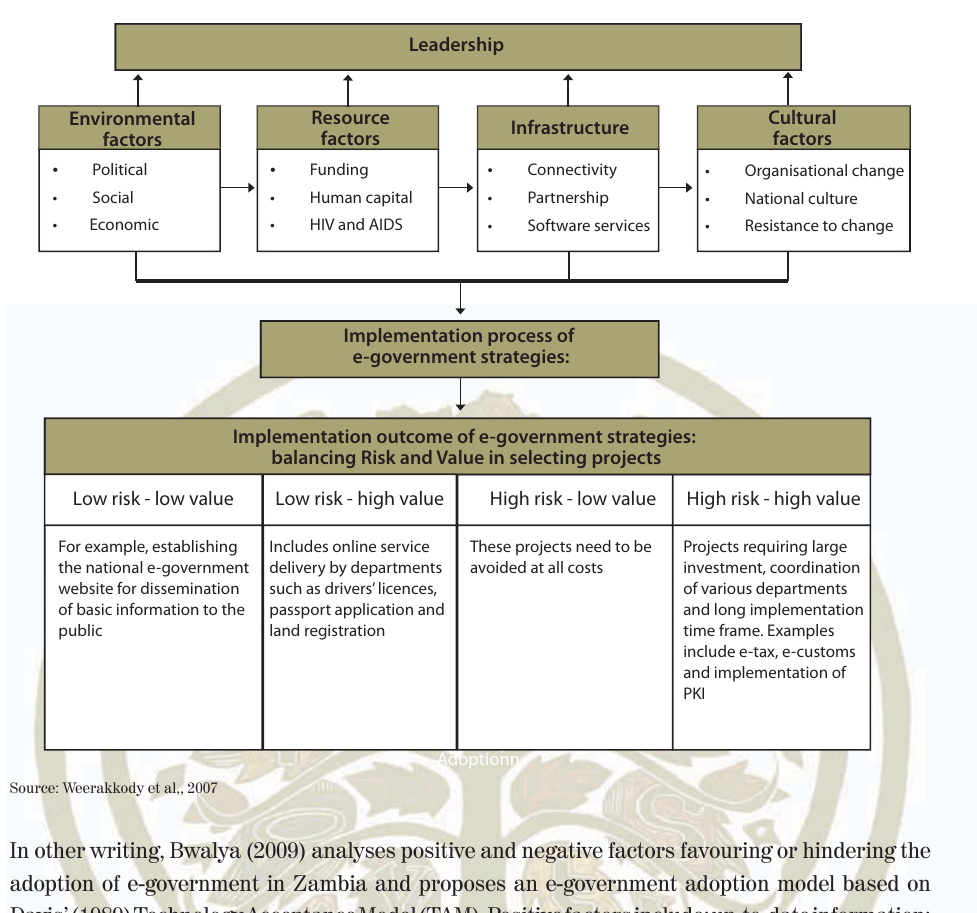
FIGURE 1: PERSPECTIVE ON A FRAMEWORK FOR E -GOVERNMENT IN